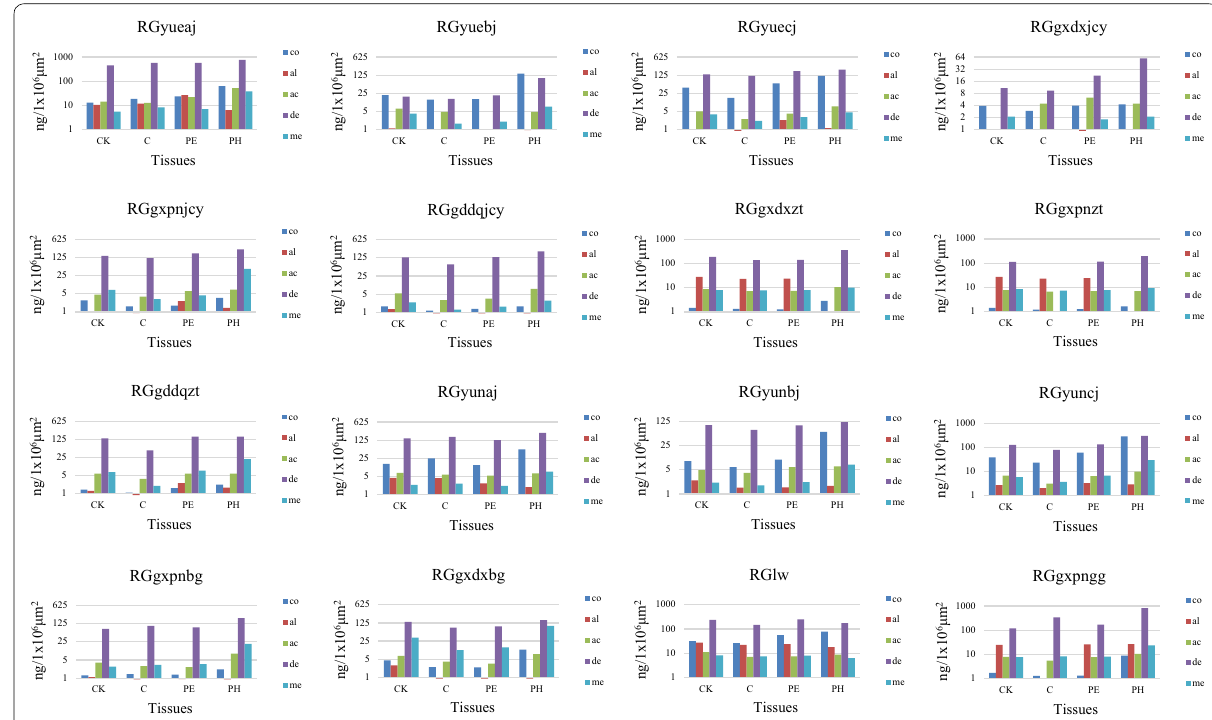
Fig. 4 The contents of coumarin (co), cinnamyl alcohol (al), cinnamic acid (ac), 2-methoxycinnamaldehyde (me), cinnamaldehyde (de) in the tissue